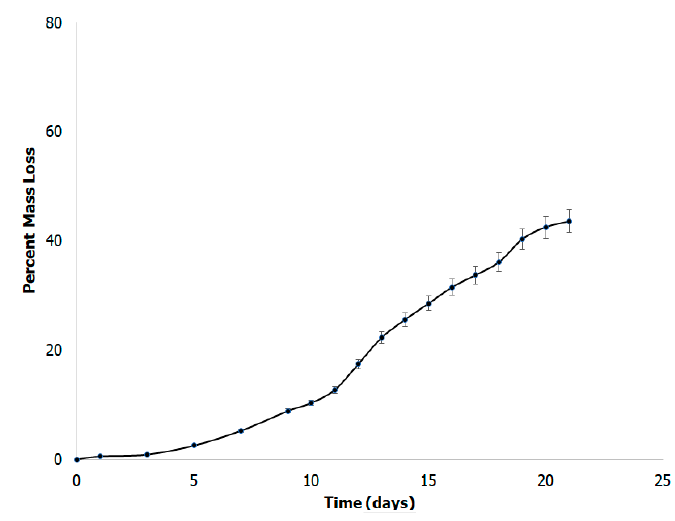
Figure 9. Biodegradation studies of the scaffolds showing mass loss over a period of 20 days.